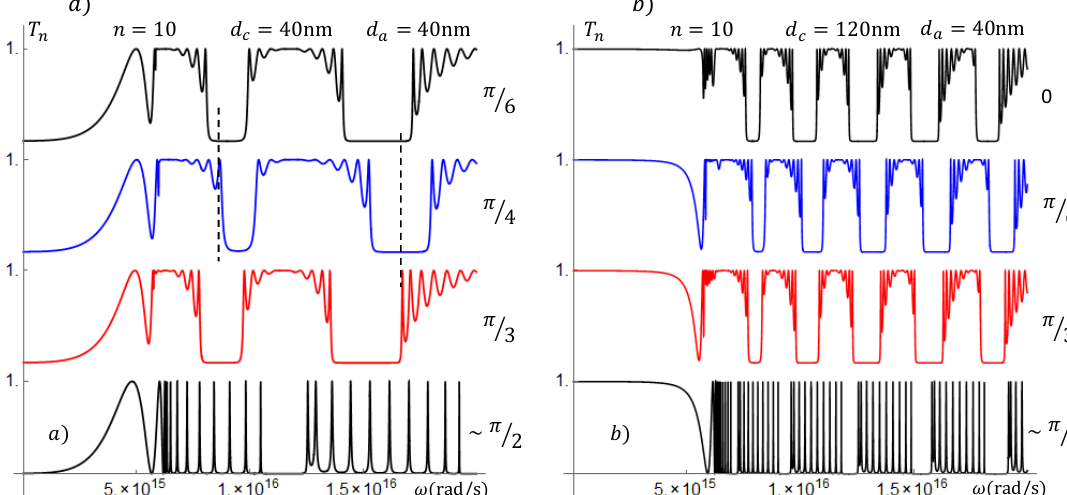
Figure 5. Transmittance as a function of the frequency through the metallic superlattices ( air / silver / air ) n where the silver and dielectric widths are ( a ) small and equal and ( b ) different with the silver slabs’ width being larger. The transmittances are shown for different incidence angles θ i indicated on the graphs. Below the plasma frequency ω p = 5.75 × 10 15 rad/s, for small widths, the transmittance is independent of the incidence angle, while for larger silver width, the metallic superlattice is almost completely transparent. For frequencies above ω p , we have wider bands for small layers’ widths and thinner bands for larger silver